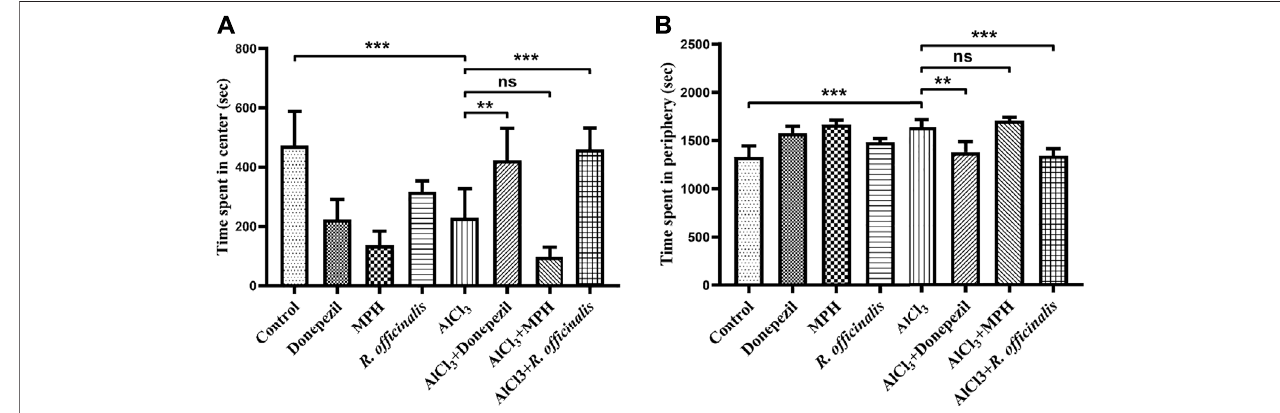
FIGURE4| Effects ofDonepezil,MPH,and R.of fi cinalis onanxiety and exploratory behaviorin theopen fi eldtest. (A) Graph depicting time spent inthe centerand (B) time spent in the periphery of the open fi eld box. One-way ANOVA followed by the Bonferroni comparison test (mean ± SEM) was applied to analyze the data using